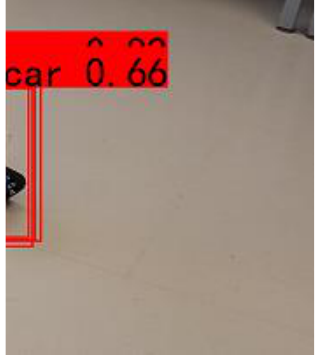
Figure 4. Duplicate detection in Faster